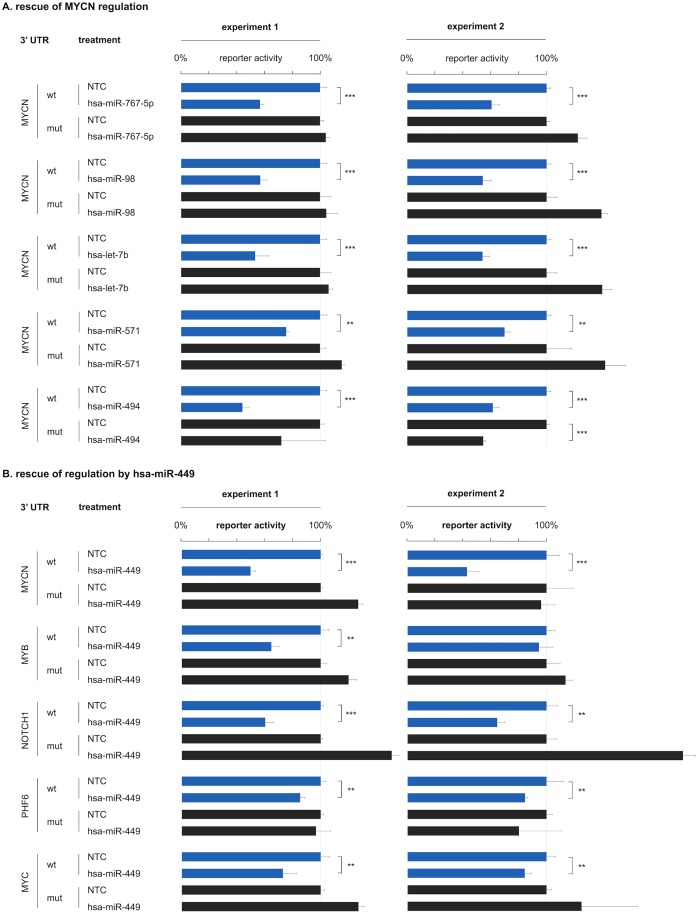
3’ UTR reporter rescue experiment.Rescue of 3’ UTR reporter regulation. (A) For four MYCN interactions significant down-regulation of reporter activity after miRNA expression modulation can no longer be demonstrated upon canonical binding site mutation (one-sided t-test; p < 0.001 ***; p < 0.01 **; wt = wild-type 3’ UTR; mut = mutant 3’ UTR) in two independently replicated reporter experiments. Reporter activity is expressed relative to non-targeting miRNA treated controls (NTC). Error bars represent standard deviations on three technical replicates. Successful rescue of MYCN regulation could only be achieved in one experiment for hsa-miR-494. (B) For four hsa-miR-449 interactions significant down-regulation of reporter activity after miRNA expression modulation can no longer be demonstrated upon canonical binding site mutation (one-sided t-test; p < 0.001 ***; p < 0.01 **; wt = wild-type 3’ UTR; mut = mutant 3’ UTR) in two independently replicated reporter experiments. Reporter activity is expressed relative to non-targeting miRNA treated controls (NTC). Error bars represent standard deviations on three technical replicates. Successful rescue of regulation by hsa-miR-449 could only be achieved in one experiment for MYB.